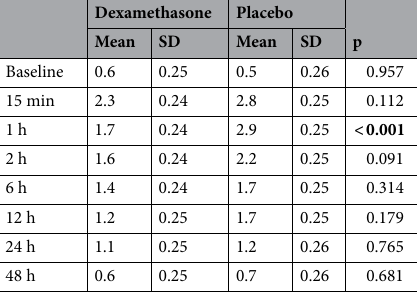
Table 3. Comparison of Taussig Scores between treatment groups at each evaluation timepoint using linear mixed model. T Student test has been used to compare estimated means. Statistically significant values appear in bold.